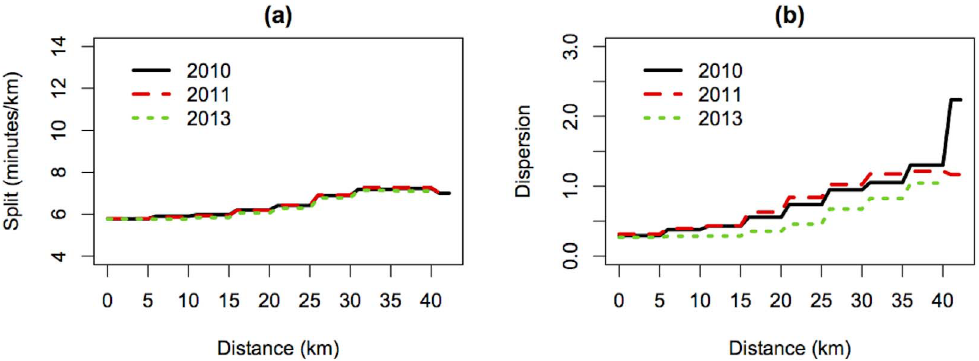
Figure 2. 2010, 2011, and 2013 Boston marathon split profile summaries. The point-wise (a) mean and (b) variance for the 2010 and 2011 Boston marathon finishers with finishing times that were slower than 4 hours, and 2013 Boston Marathon racers who made it to the 40 km mark and either (i) did not finish or (ii) had a finishing time slower than 4 hours. These summaries for the marathons are very similar, and the variability increases later in the race.